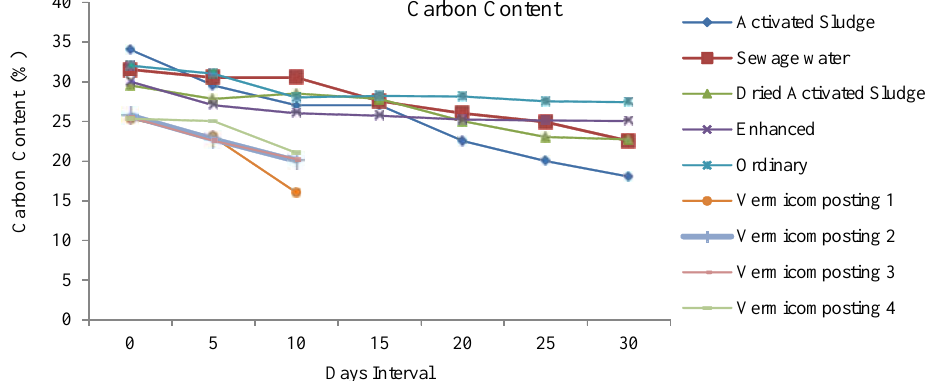
Fig. 1: Comparison between the carbon content of initial and final samples of the compost